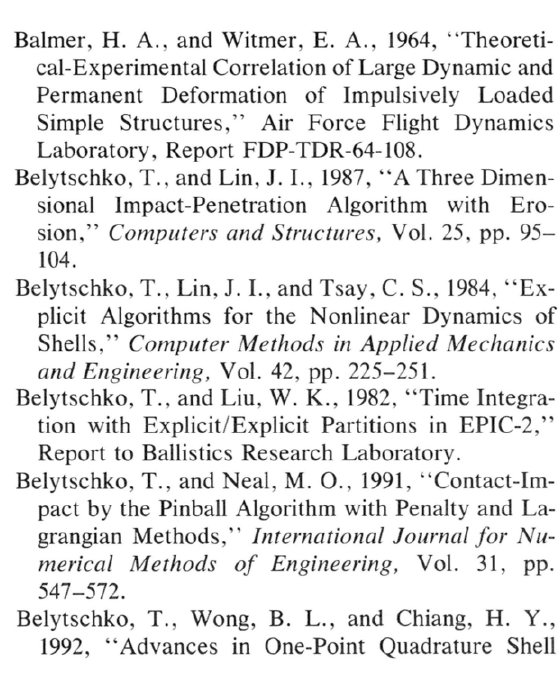
FIGURE 10 Original and deformed shapes of a vehicle front end with pinball contact impact